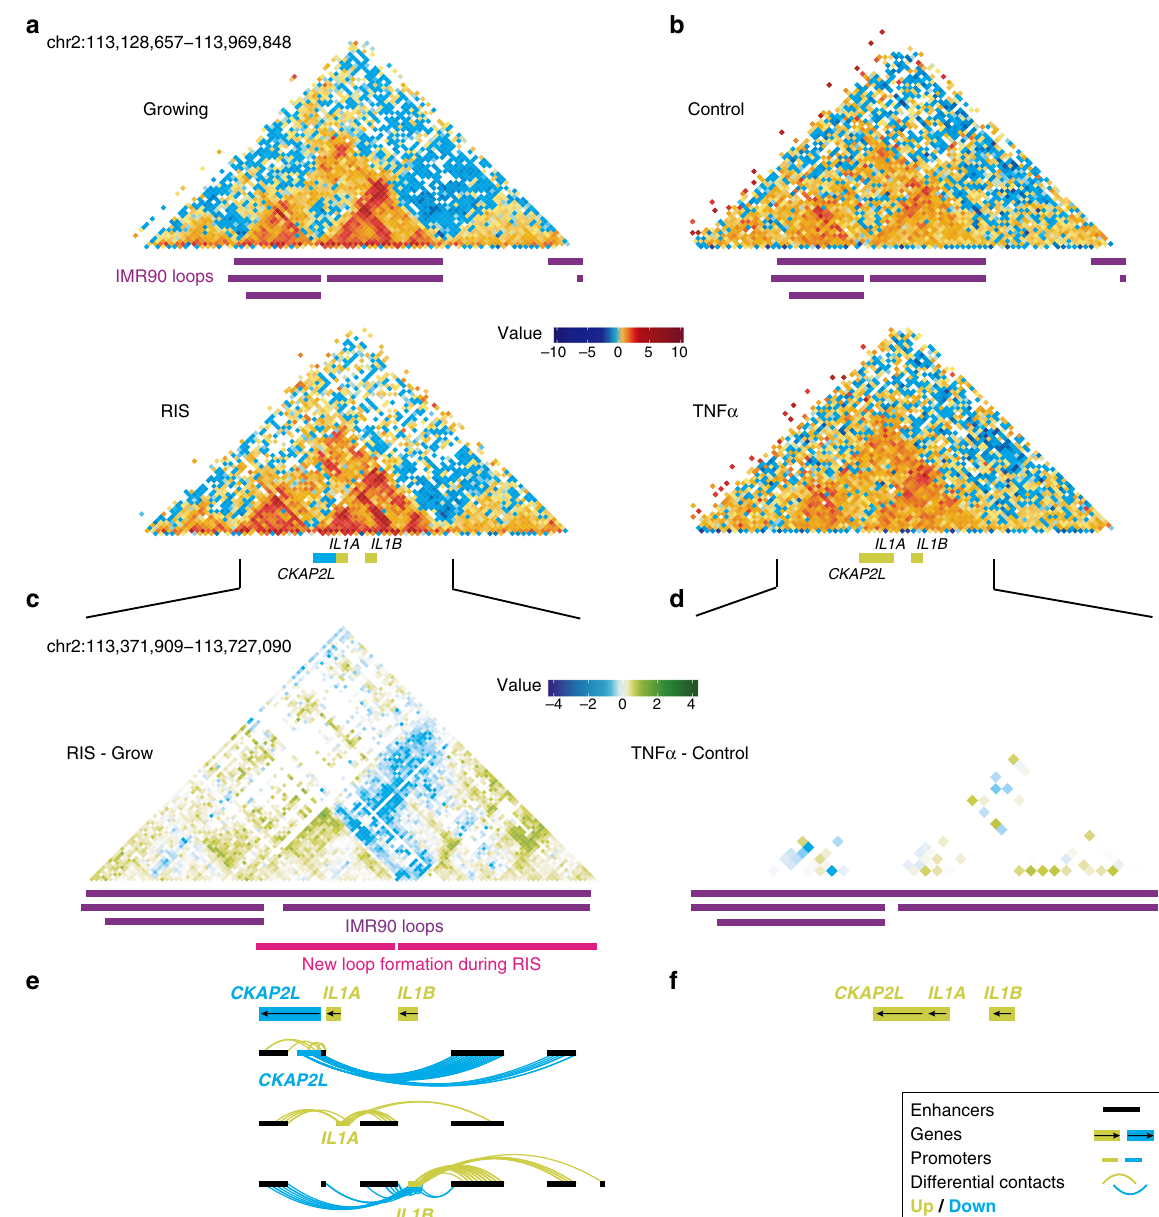
Fig. 2 Reorganization of the local chromatin neighbourhood at the IL1 locus. a , b Hi-C matrices (10 kb resolution) of the IL1 locus corresponding to growing and RIS IMR90 cells ( a ) and control and TNF α -treated IMR90 cells from Jin et al. 15 ( b ). c Differential capture Hi-C matrix at the IL1 locus (log-fold change of RIS/growing interactions estimated genome-wide using all replicates) at HindIII resolution, with annotated growing IMR90 loops (from Rao et al. 13 ) and inferred new loop formation in RIS cells. d Differential Hi-C matrix at the IL1 locus (log-fold change TNF α ) at 10 kb resolution. e , f Signi fi cant differential enhancer-promoter contacts between promoters of differentially expressed genes at the IL1 locus and associated enhancers, aligned with ( c ) and ( d ), respectively.